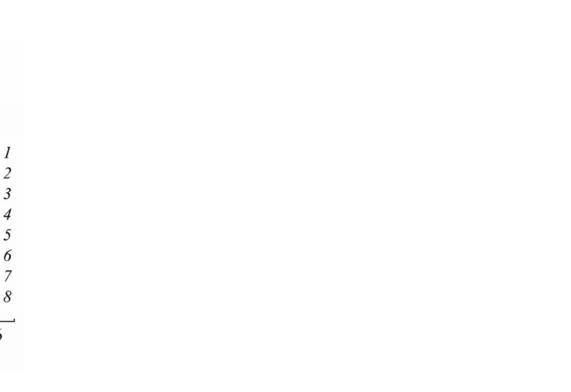
Figure 28. Conductivity dependence on the moisture content for sulfonate cation-exchange MF-4SC (1–4) and carboxylic F-4CF (5–8) perfluorinated membranes in various ionic forms. Membrane ionic forms: (1, 5) H + , (2, 6) Li+, (3, 7) Na+, (4, 8) Cs+. Reprinted with permission from [20]. Copyright 2011 Elsevier.